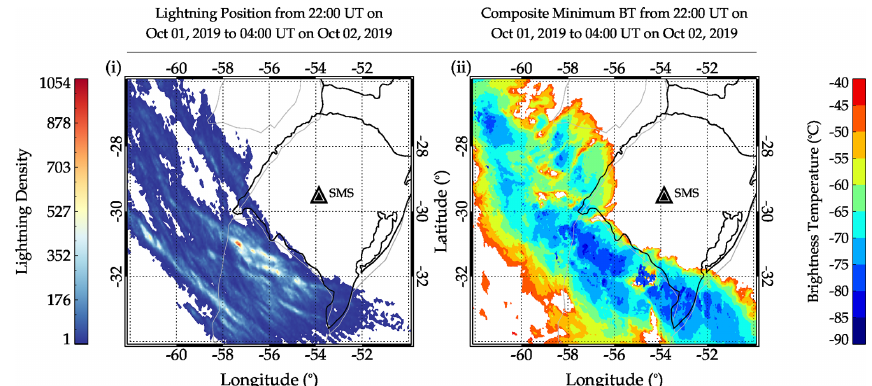
Figure 15. Comparison between the spatial distribution of lightning density and composite GOES-16 IR cloud top brightness temperature images from 22:00UT on 1 October 2019 to 04:00UT on 2 October 2019. The filled black triangle within a white triangle shows the location of the Southern Space Observatory.